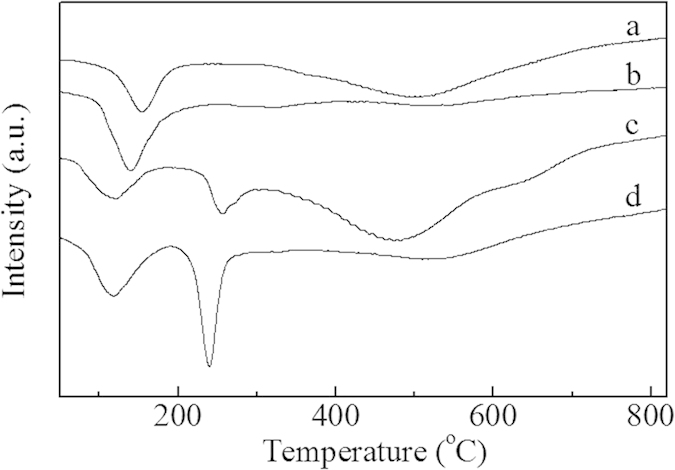
H2-TPR profiles for the Ru catalysts:(a) Ru/CNTs-in; (b) Ru/CNTs-out; (c) Ru0.25WOx/CNTs; (d) Ru0.50WOx/CNTs.